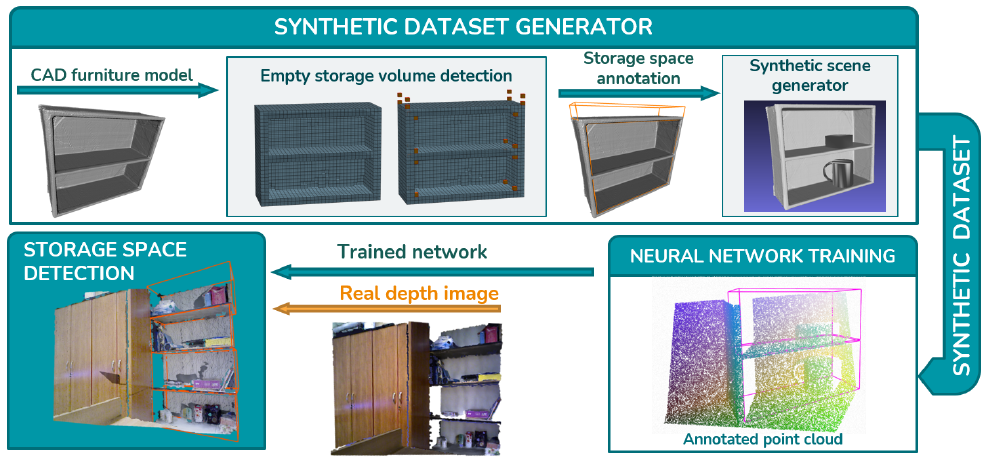
Figure 1. The method